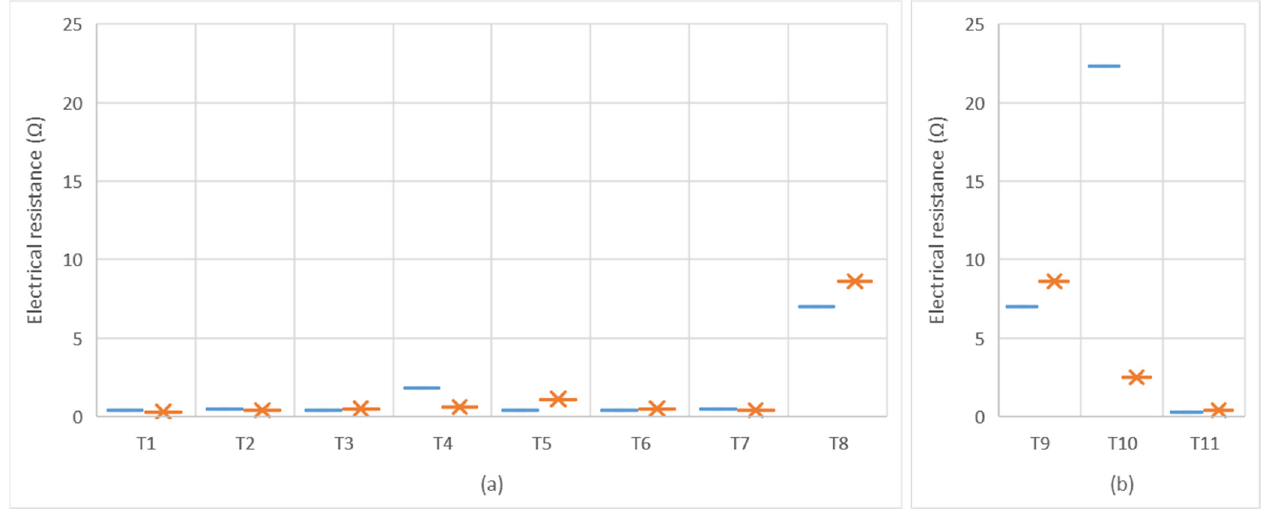
Figure 2. Graphic representation of the electrical resistance of the printings ( ) measured on warp direction and ( ) measured on weft direction. ( a ) Electrical resistance affected by the structural variations of the textiles; and ( b ) Electrical resistance affected by the material composition of the textiles.